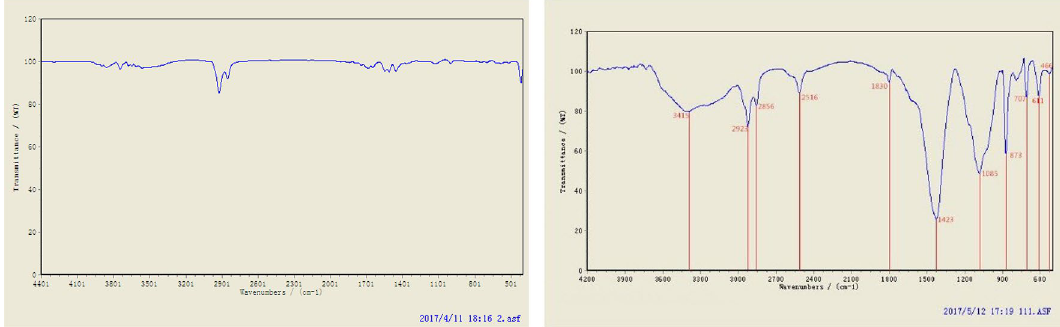
Fig. 5 Results of infrared spectrum analysis of the blockage samples (YB27-3H and YB102-1H)